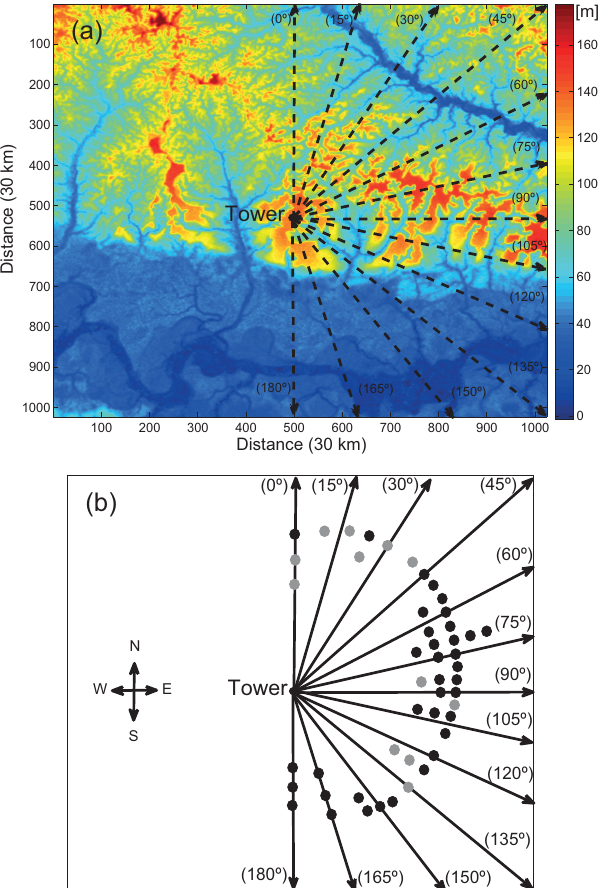
Figure 15. (a) Area of approximately 900km 2 surrounding the ATTO site. The axes represent the directions (0, 5, 10, 15, 175, 180 ◦ ) from the ATTO tower. The color scale represents terrain el- evation in meters above sea level. (b) Schematic with axes corre- sponding to (a) ; the black dots indicate gravity wave events induced by terrain undulations and the gray points represent gravity wave events not induced by terrain